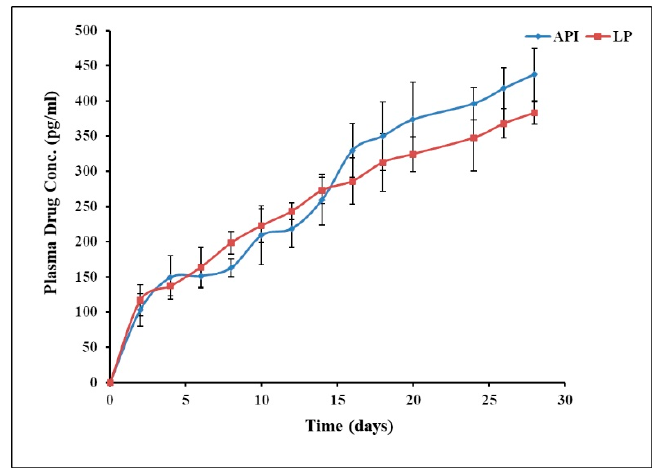
Figure 5. In vivo profile of levonorgestrel liposome-loaded microneedle versus levonorgestrel (API) loaded microneedle.